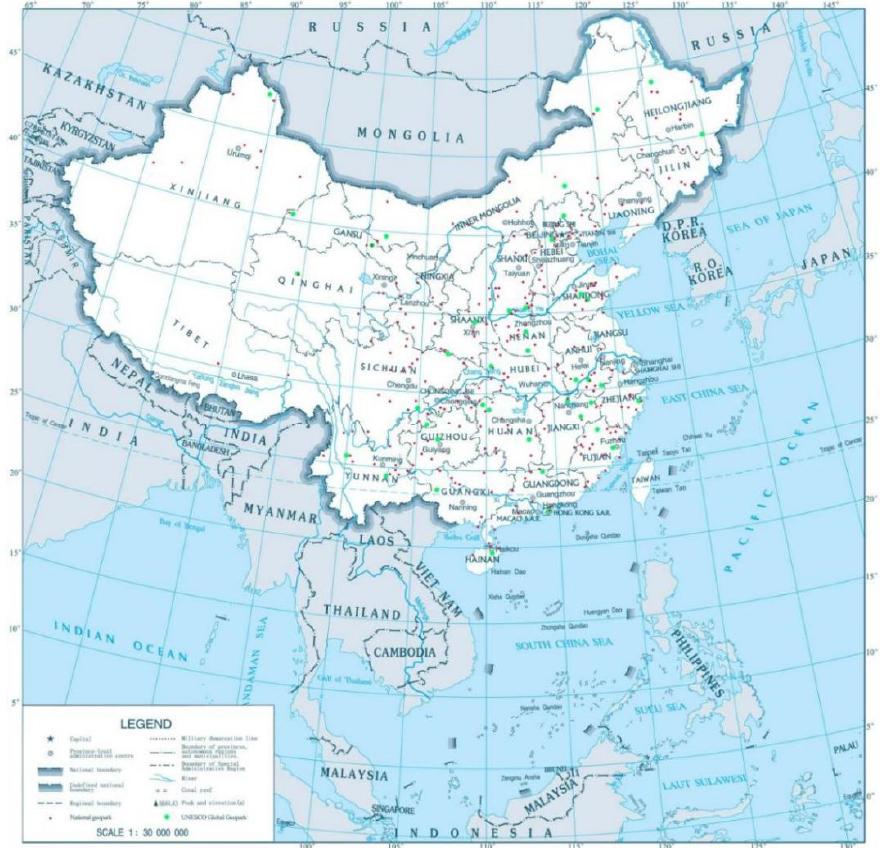
Figure 6. Distribution of Geoparks in China.